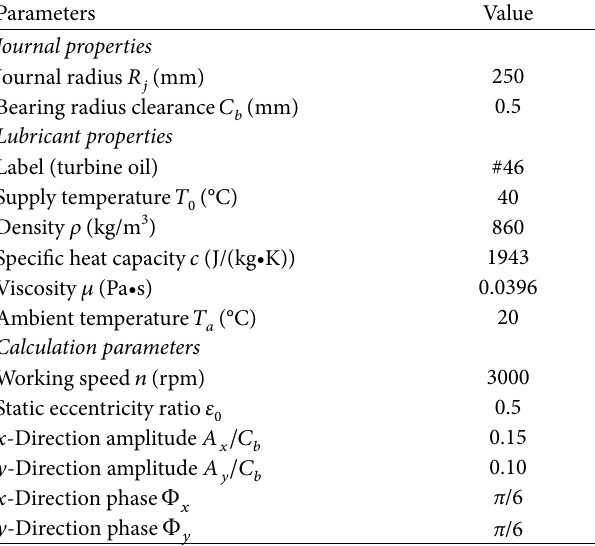
Table 1: Parameters for journal and